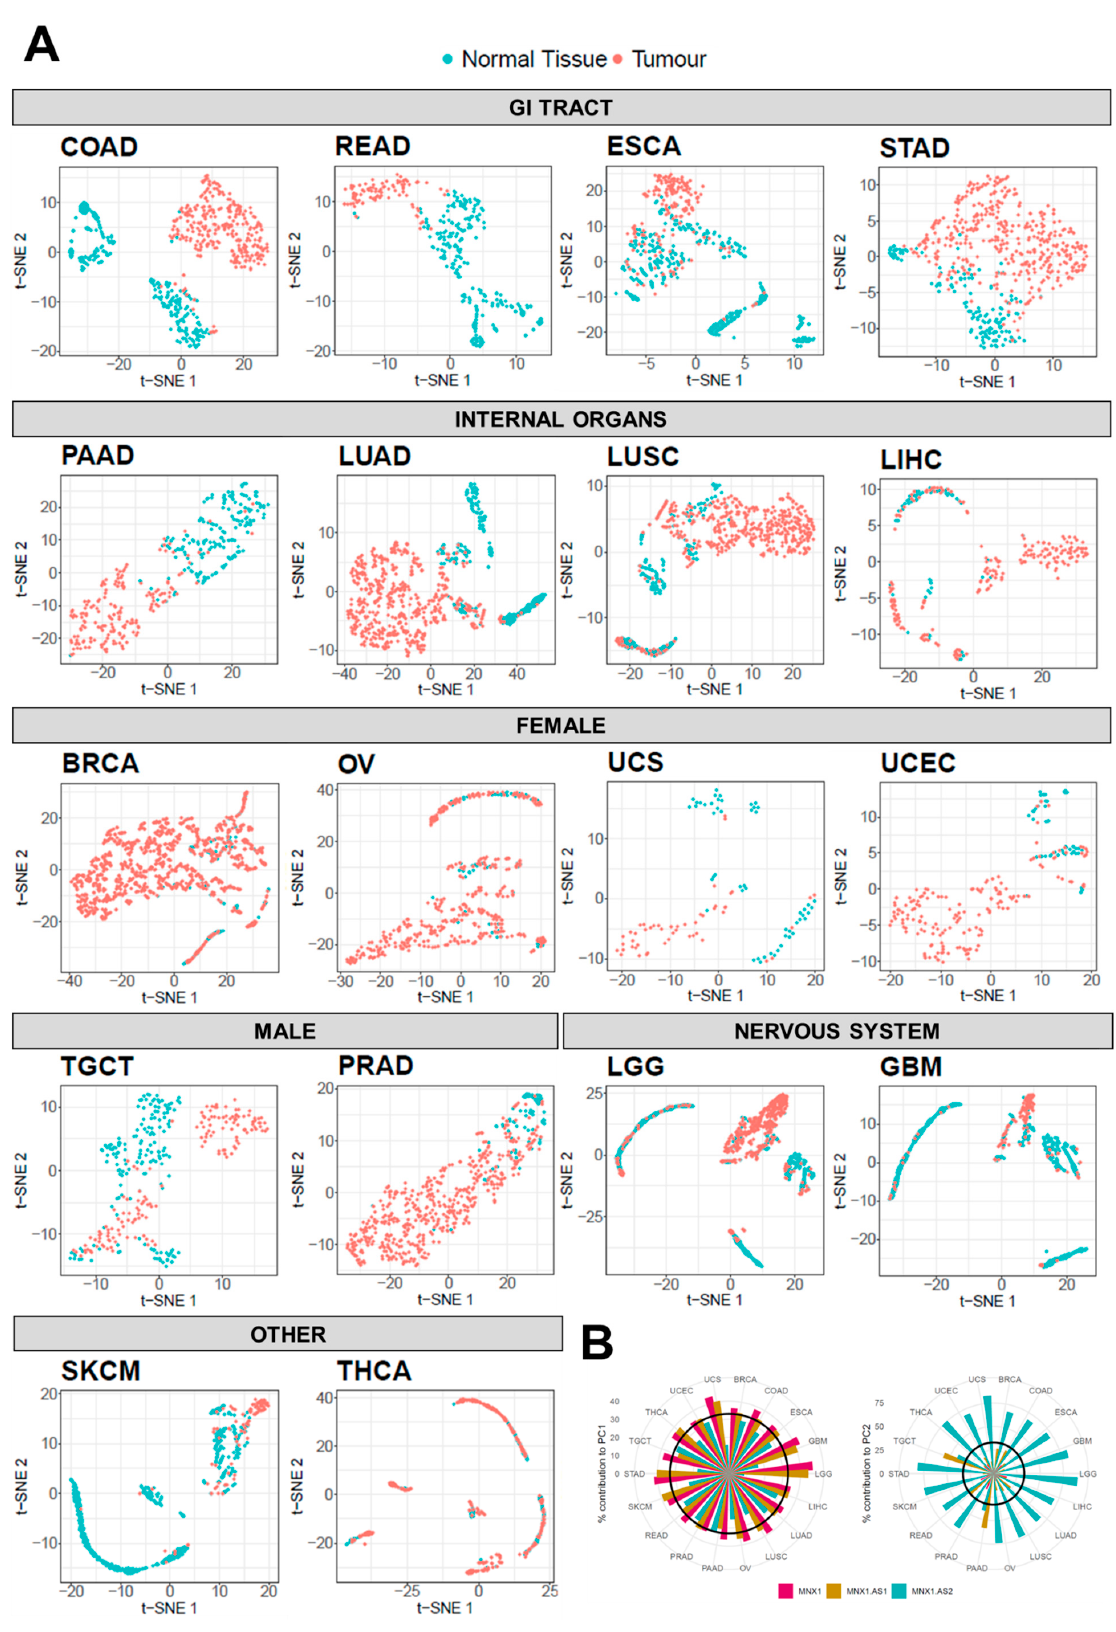
Figure 3. t-SNE clustering analysis of normal vs. tumour samples based on the combinatorial expressions of MNX1 , MNX1 - AS1 , and MNX1 - AS2 . ( A ) The visualization of multi-gene